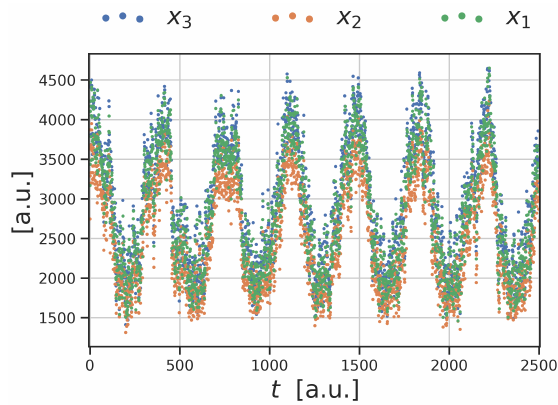
Figure 3. Small interval of the three employed signals. Their high correlation is used by the method to detect possible